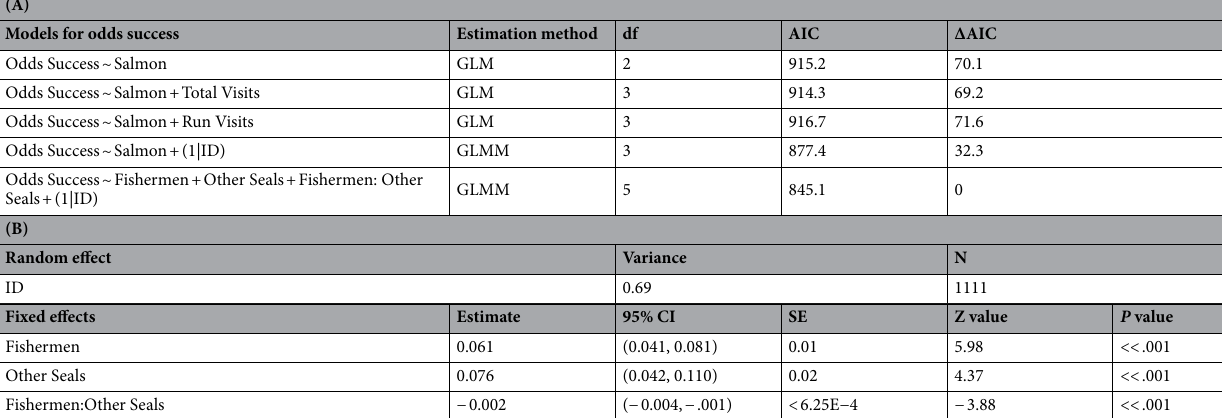
Table 2. (A) Model results predicting the odds of success of a single foraging attempt by an individual harbor seal relative to number visits for that seal as well as identity of the seal in question. The change in AIC is the difference between the tested model and the model of best fit (as determined by the lowest AIC value). (B) GLMM model output for the final, most parsimonious model describing odds of success for a given